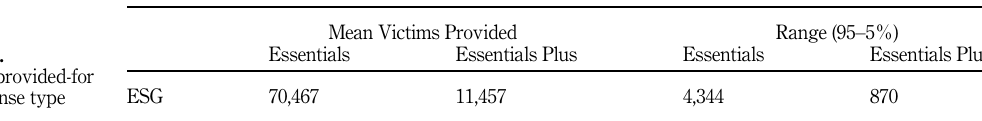
Table 6. Victims provided-for by cargo loadout type